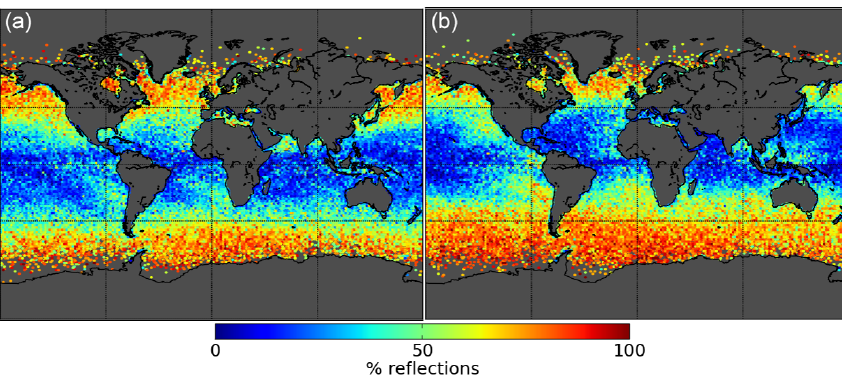
Figure 4. Statistics of GPSRO events identified as showing a reflection, over the ocean, obtained with the COSMIC constellation from 2006 to 2015. Percentage is shown during January and February (a) and during July and August (b) . Note that the colour scale is different from Fig. 3. When the number of events per pixel is too small to derive sensible statistics, these are not shown. In polar oceans, reflections are also very frequent (see also Fig. 7). See also Movie 2, which shows the seasonal cycle of the median SVM output value over ocean.